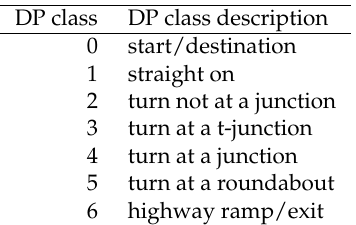
Table 3: Decision point classes ( DPC